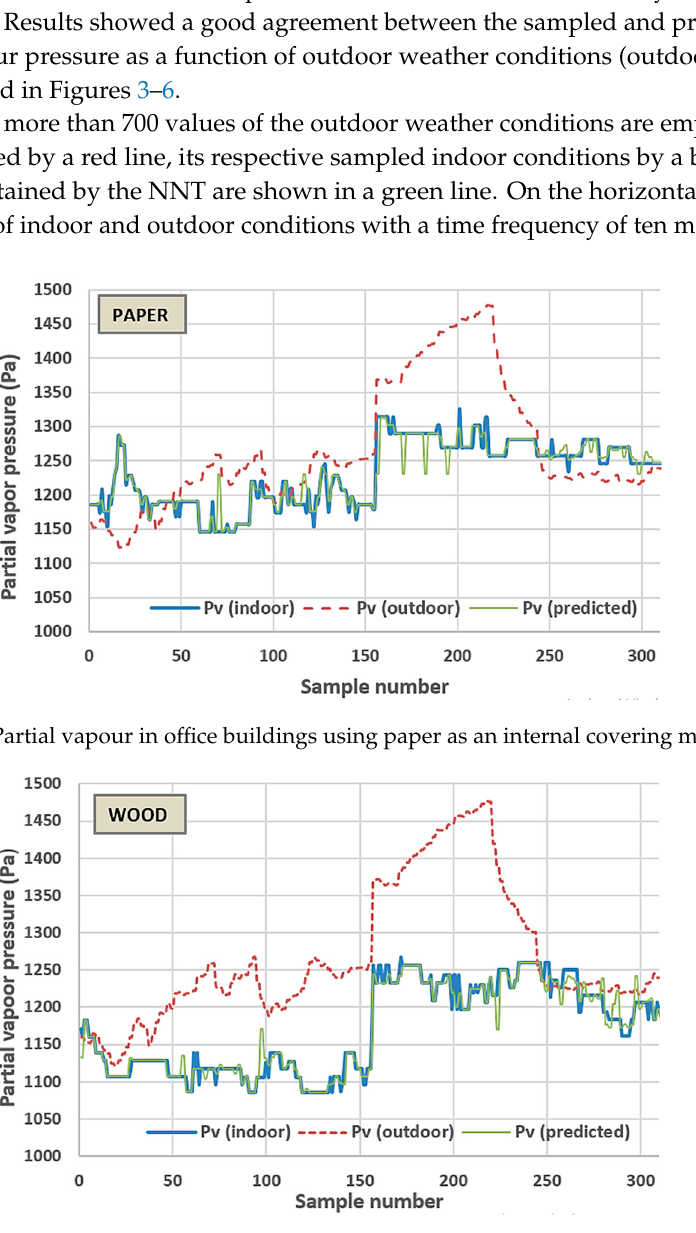
Figure 4. Partial vapour in office buildings with wood as an internal covering material.